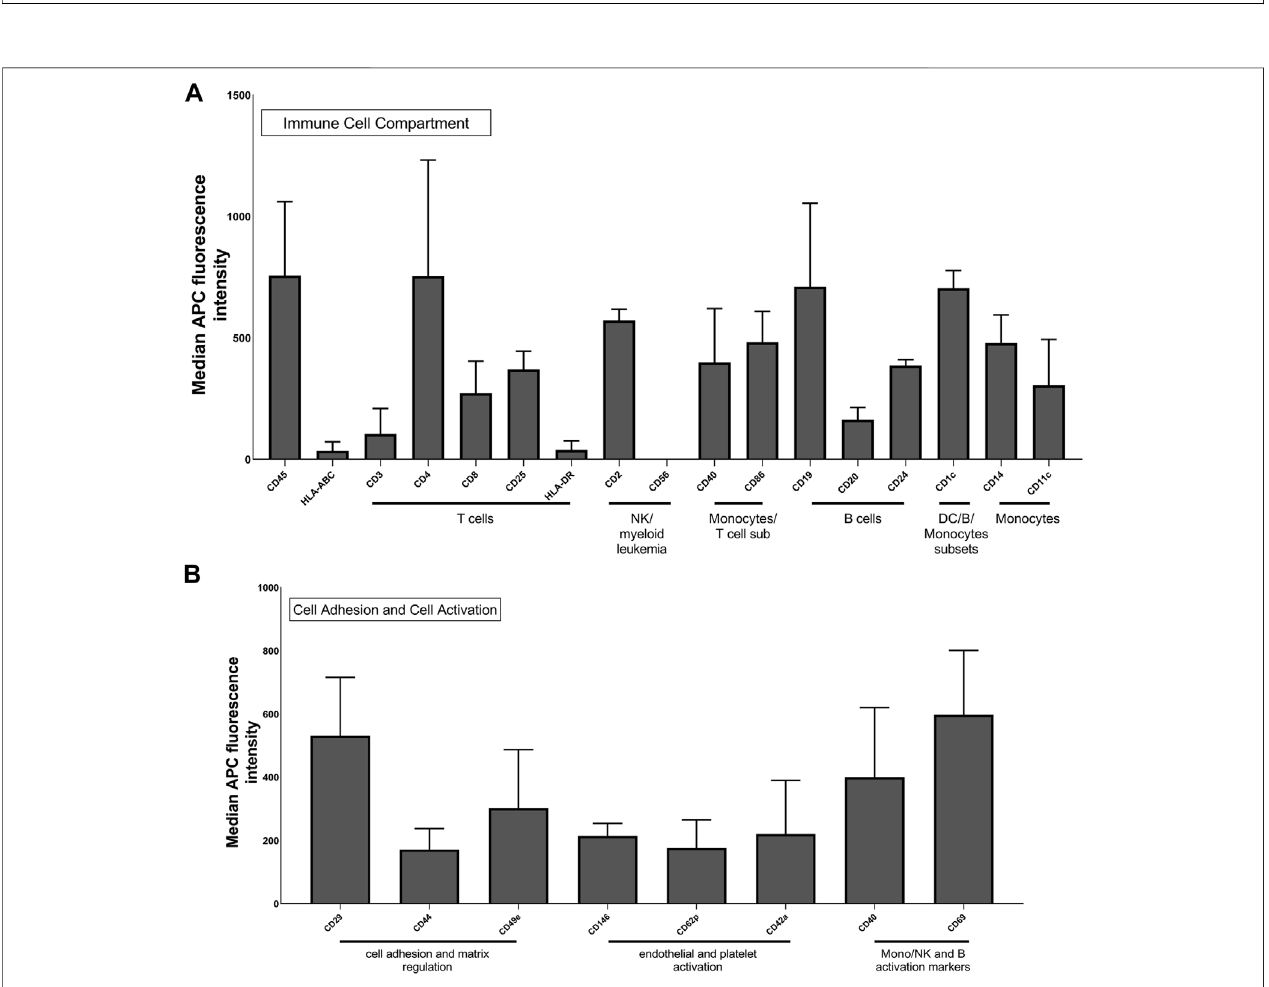
Frontiers in Bioengineering and Biotechnology |